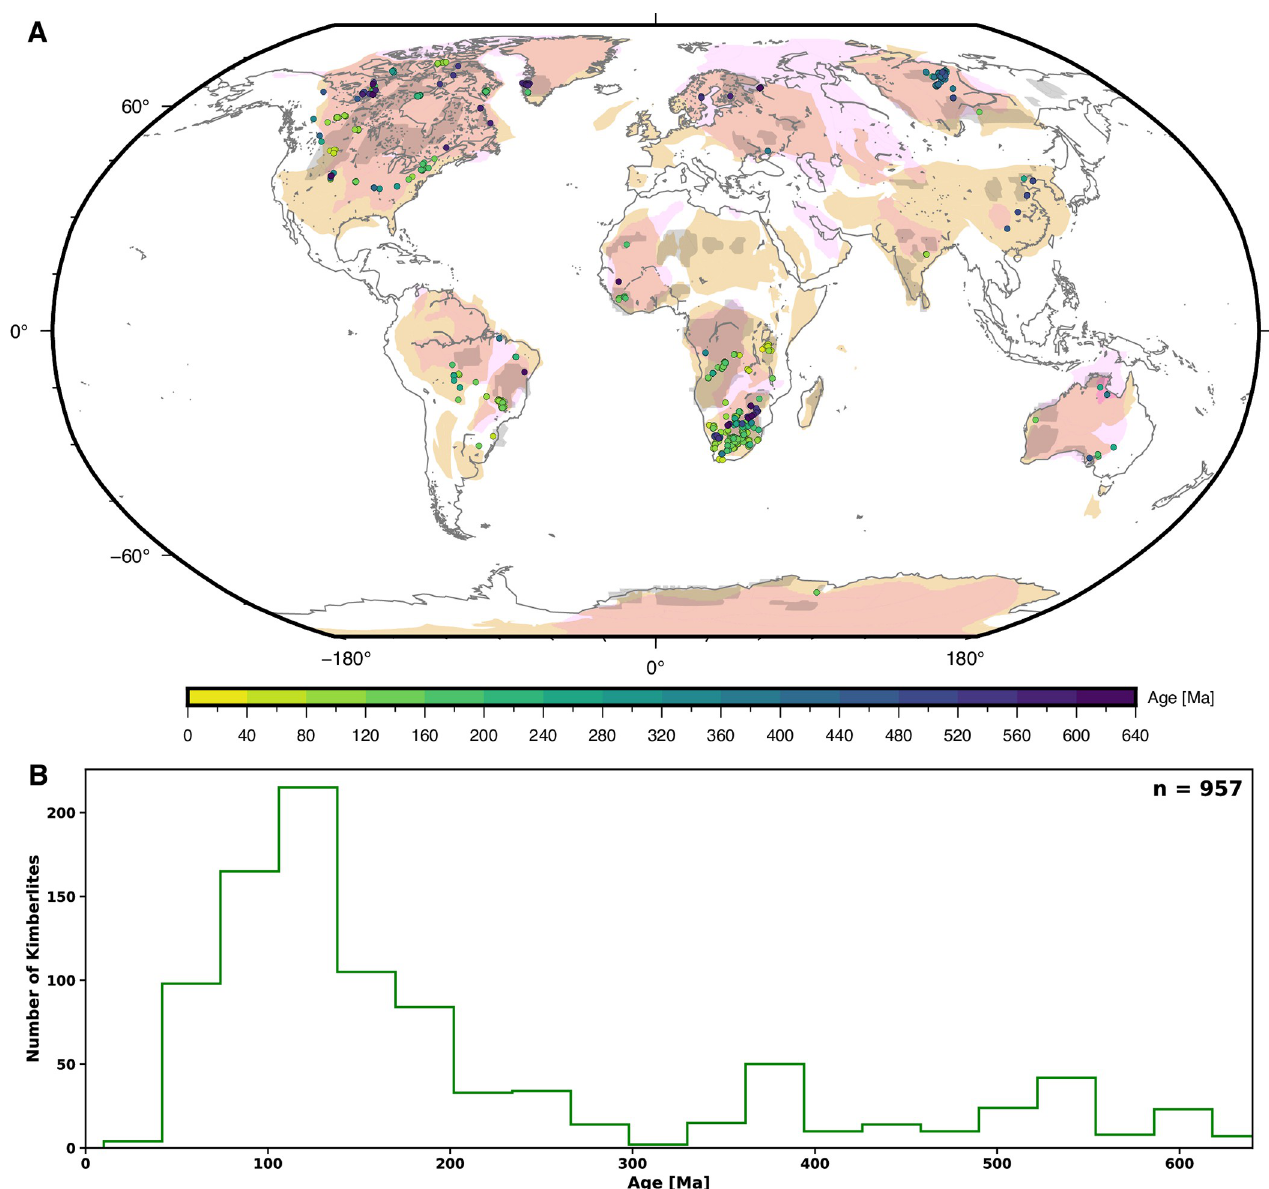
Fig 1. Distribution of thick or ancient lithosphere and kimberlite eruptions. A/ 957 kimberlite eruptions from ref. [22] from 640 Ma to the present, sampled in 20 Myr increments and coloured by age, and outlines of thick or ancient lithosphere considered in this study: magenta polygons show lithosphere thicker than 150 km in all four lithospheric thickness models considered in ref. [5], beige polygons are tectonic blocks from ref. [38] and grey polygons are blocks of tectonothermal age greater than 2.5 Ga from ref. [46]. Coastlines are shown in grey. This figure was created with GMT6 [47] and the Global Self-consistent, Hierarchical, High-resolution Geography Database (GSHHG) coastlines are republished from [48] under a CC BY license, with permission from Paul Wessel, original copyright 1996. B/ Histogram showing the temporal distributions of kimberlites occurrences from ref. [22] from 640 Ma. None of the data in this figure are